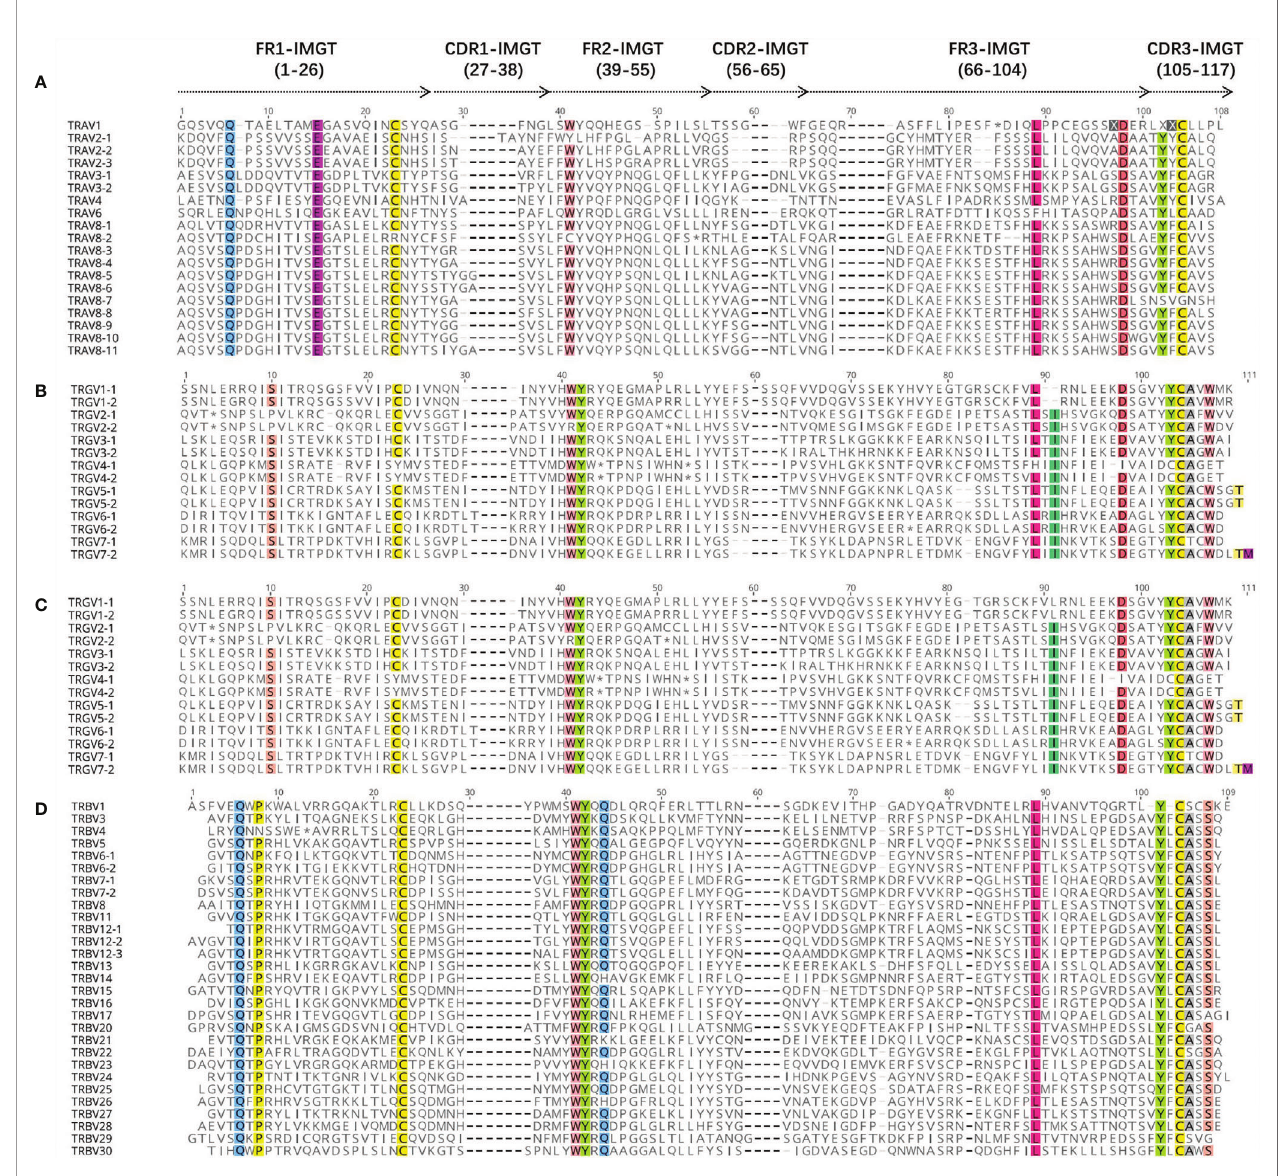
FIGURE 6 | The international ImMunoGeneTics information system (IMGT) Protein display of the bat TRAV (A) , TRDV (B) , TRGV (C) , and TRBV (D) genes. TRAV genes are only shown at TRAV1 to TRAV10. The description of the FR-IMGT and CDR-IMGT is according to IMGT unique numbering for V-region. The four conserved amino acid of the V-domain (1st-CYS 23, CONSERVED-TRP 41, hydrophobic AA 89, 2nd-CYS 104) are indicated in